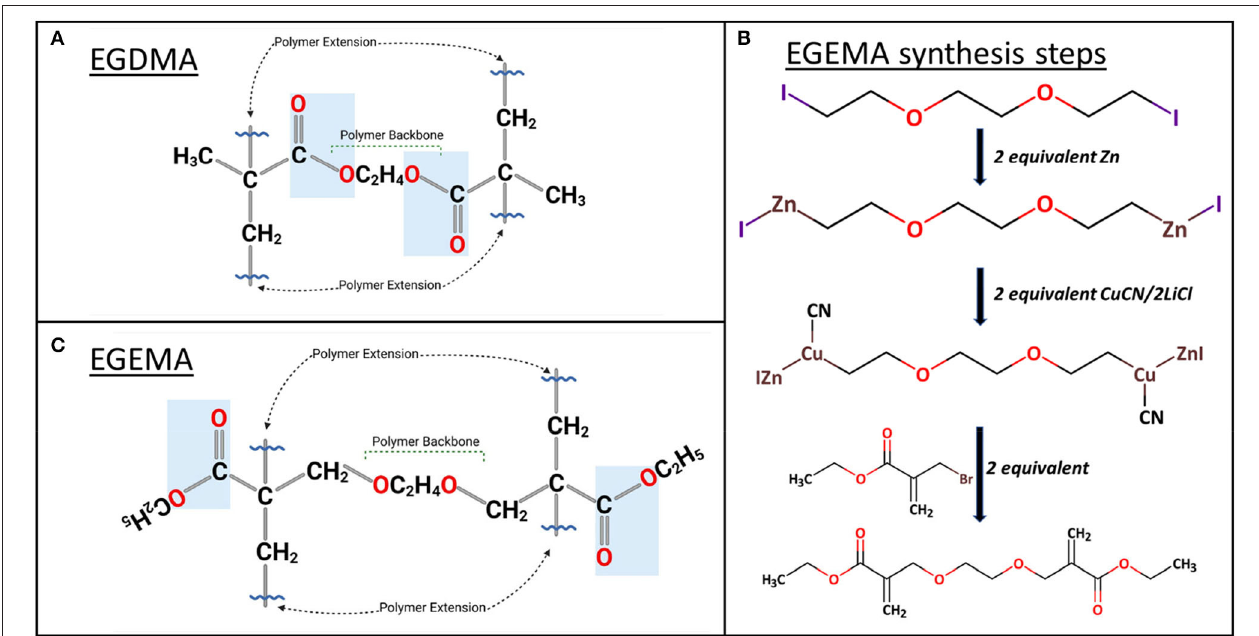
FIGURE 1 | (A) molecular structure of EGDMA homo-polymerization where ester groups are within the polymer backbone. (B) EGEMA synthesis steps. (C) In EGEMA homo-polymerization, ester groups are external to the polymer backbone, flipped along the carbon axis, across the vinyl group.